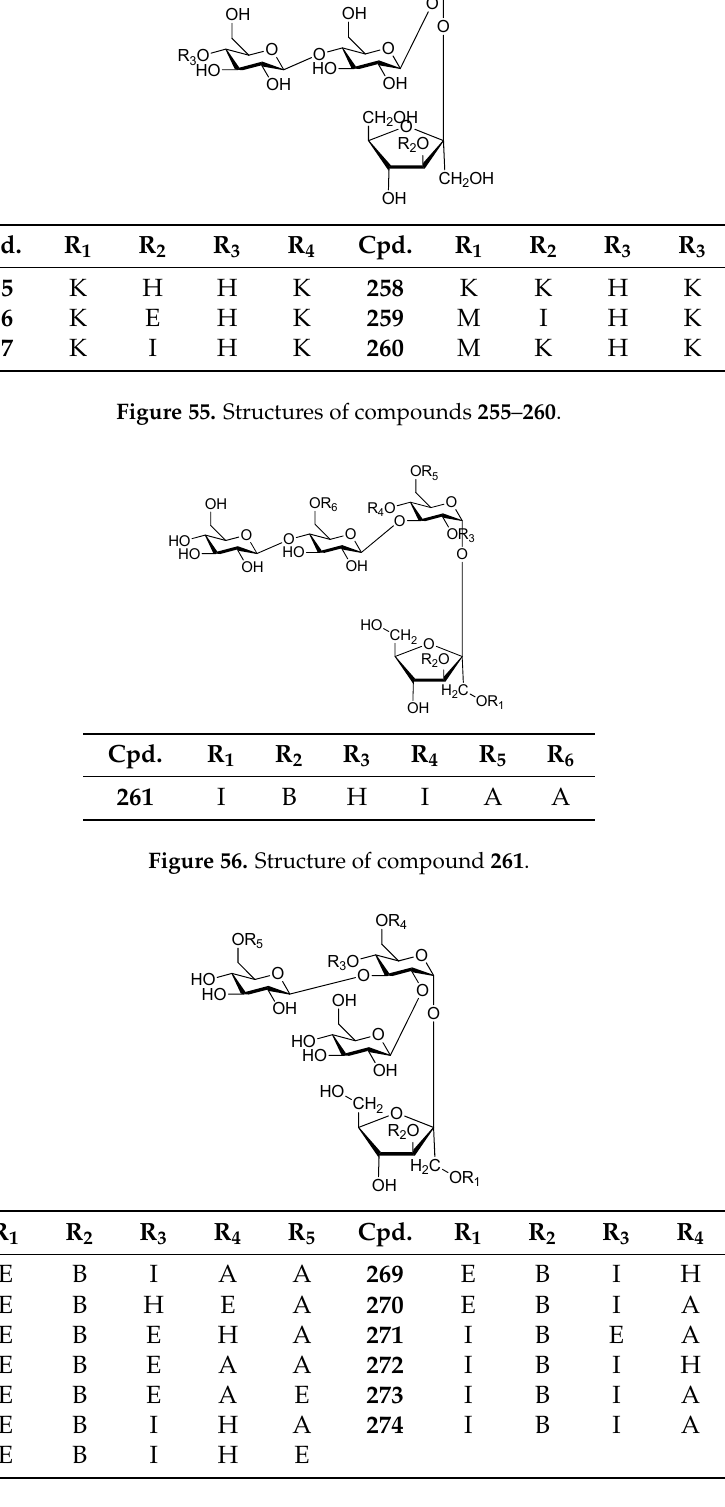
Figure 57. Structures of compounds 262 – 274